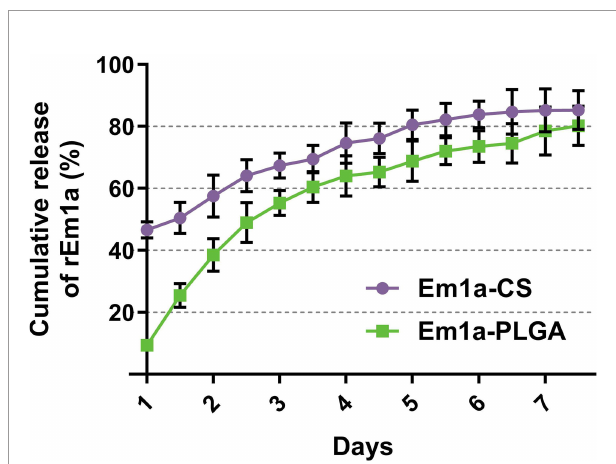
FIGURE 4 | In vitro release of recombinant Em1a proteins from Em1a-PLGA and Em1a-CS nanospheres. The concentrations of free proteins were investigated by the BCA assay. Three independent experiments were carried out, and each sample was measured once. Values were presented as the mean ± SD (n = 3).